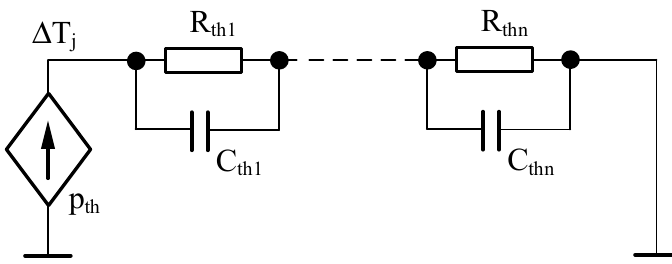
Figure 2. Network representation of the used thermal model of a SiC-MOSFET.